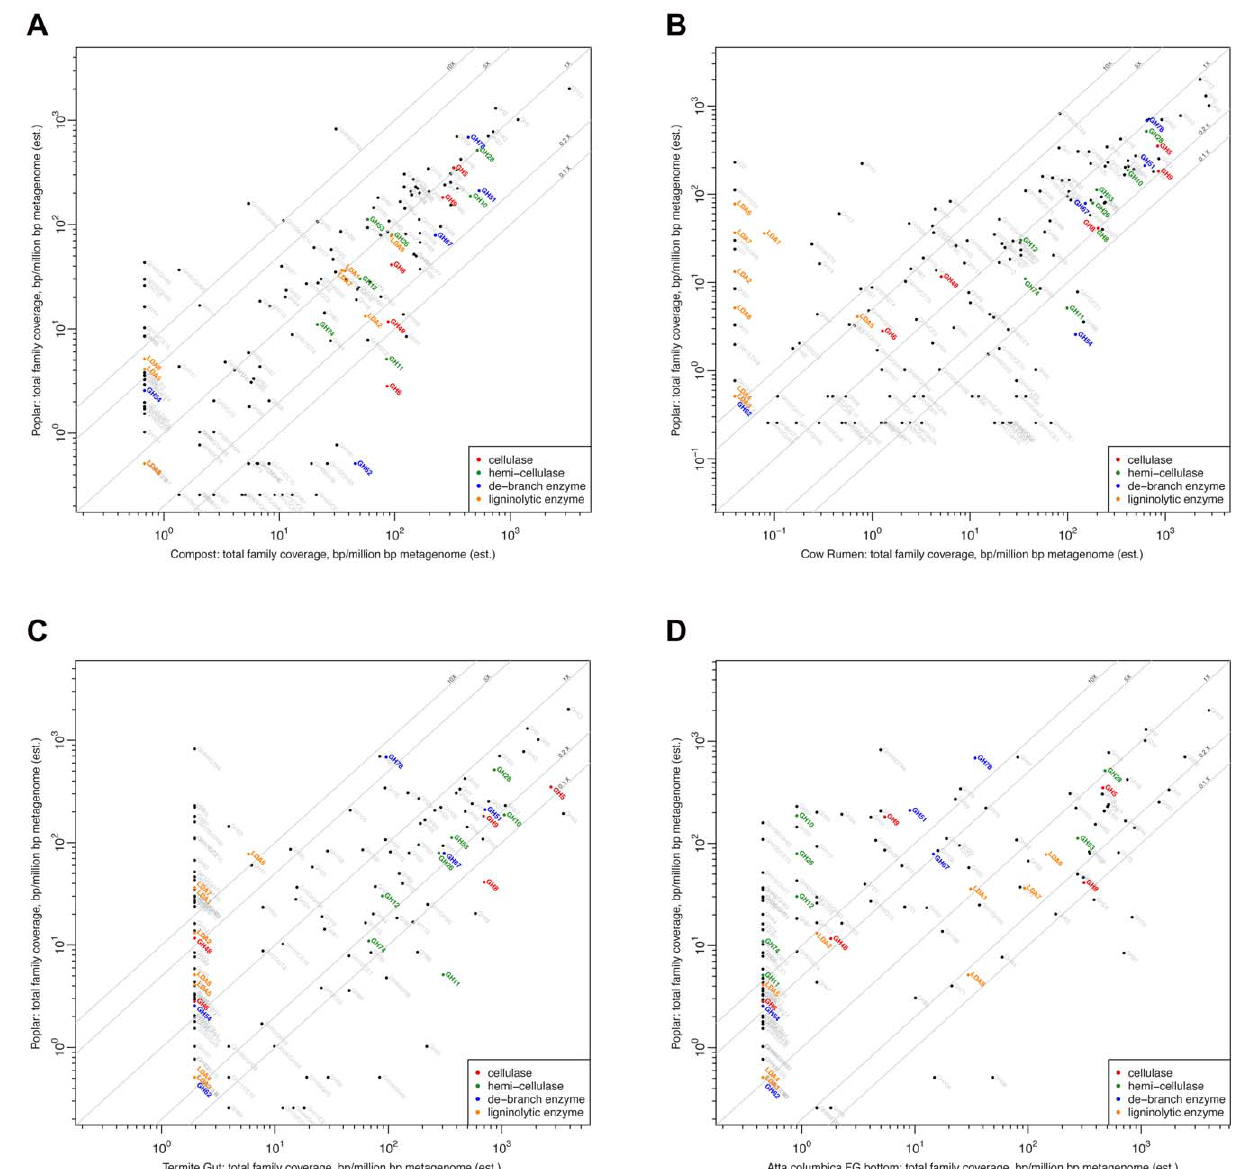
Figure 7. Comparison for the various metagenomes of the total coverage per family of biomass modifying enzymes. This included cellulases, hemicellulases, debranching enzymes and enzymes homologous to lignolytic enzymes. The comparisons for the poplar woodchip bioreactor community with compost, cow rumen, termite hindgut, and fungal garden bottom are presented in Figures 7A, 7B, 7C and 7D,